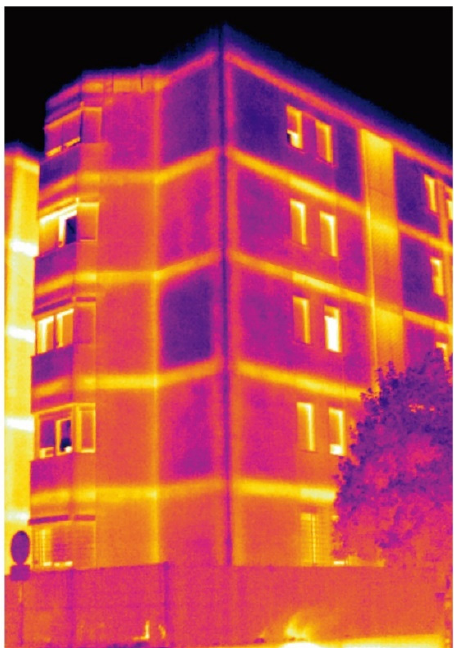
Figure 3. Thermography with thermal bridges found in the building.